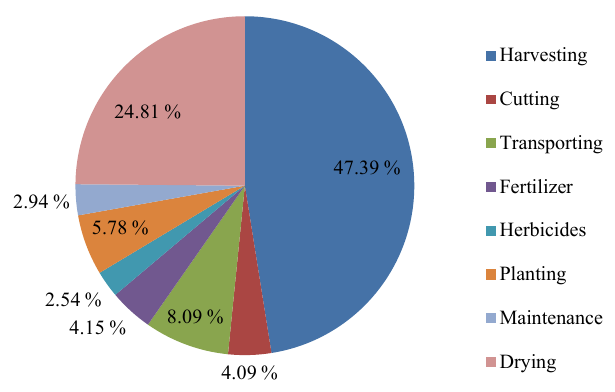
Fig. 4. The prime cost structure of willow